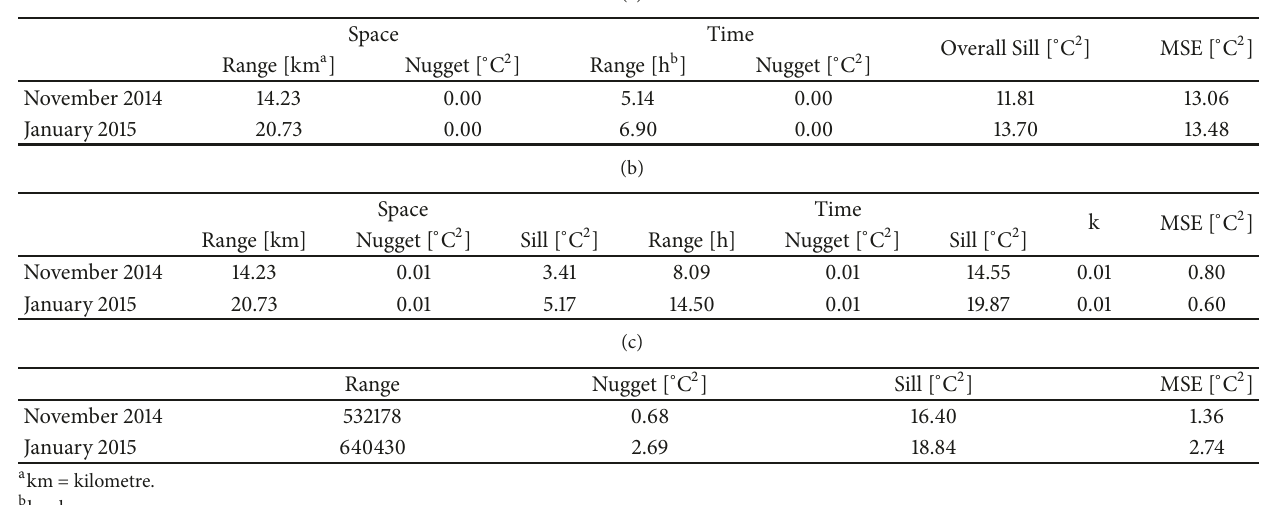
Table 1: Fitted model parameters for the spatiotemporal variogram. (a) Separable covariance model. (b) Product-sum covariance model. (c) Metric covariance model.